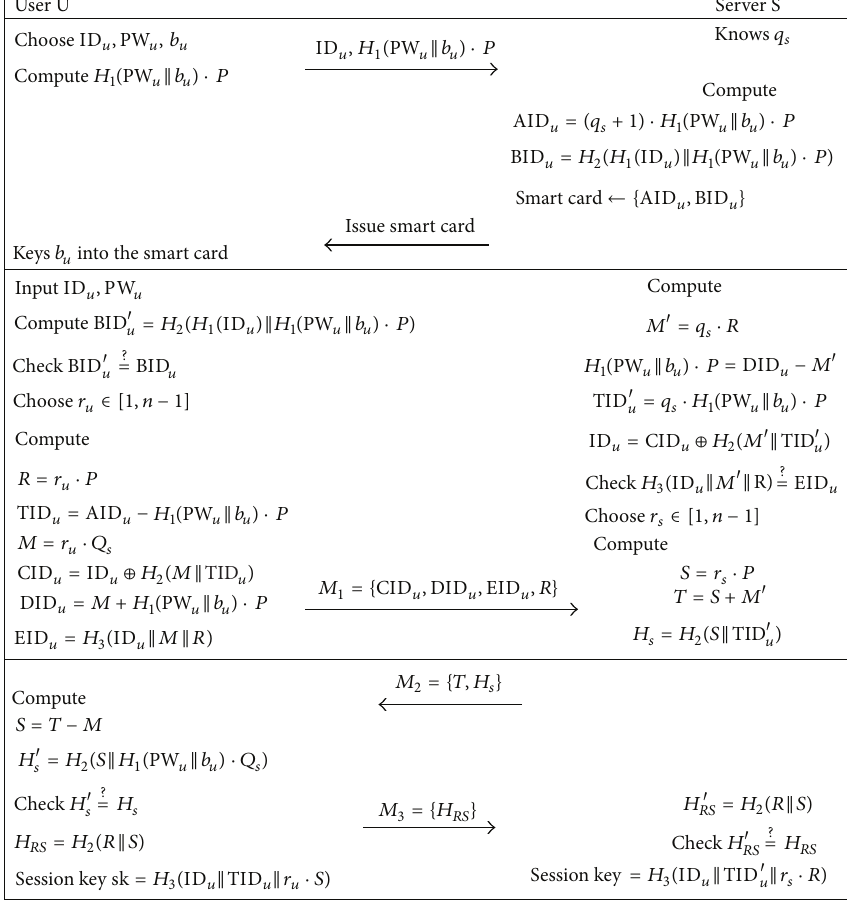
Figure 1: The proposed